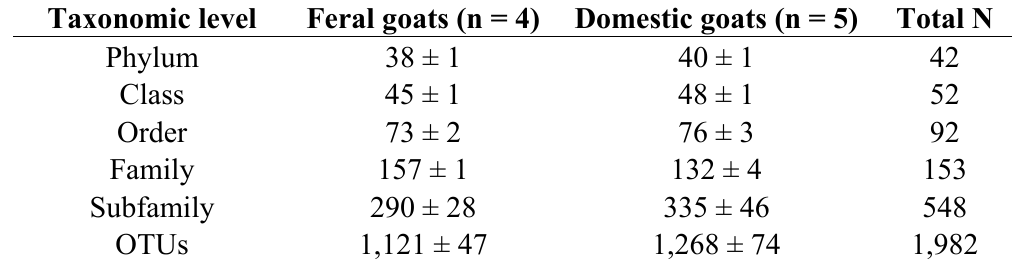
Table 1. Number of bacterial taxonomic groups (OTUs ± s.e.) in feces from feral and domestic goats.